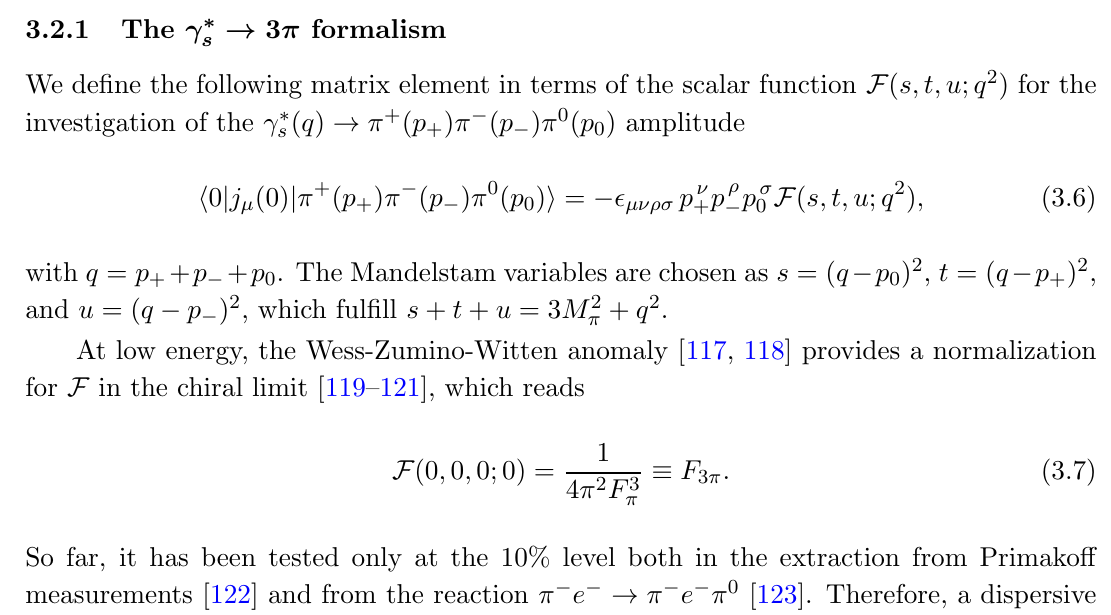
Figure 5. Two-body unitarity relation for the (cid:13) (cid:3) for three-body unitarity in (cid:13) (cid:3) part of the diagram in the dashed box can be viewed as a special case of the full (cid:25) + (cid:25) (cid:0) (cid:25) 0 amplitude. The gray blob labeled P refers to the P -wave (cid:25)(cid:25) scattering